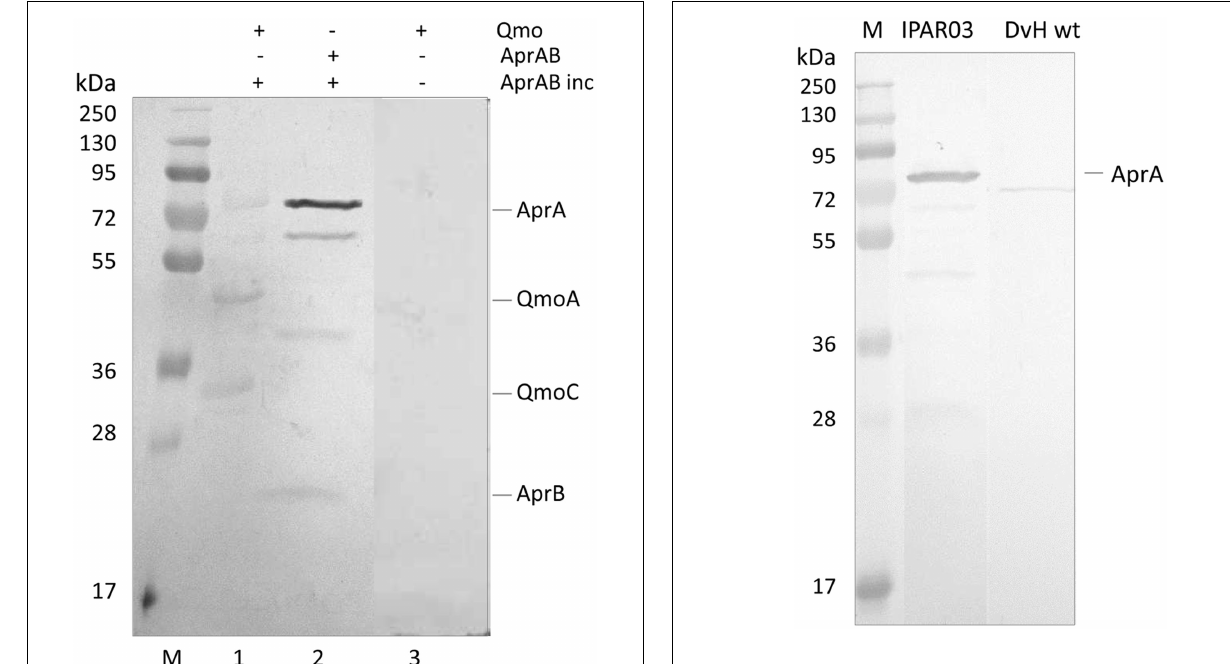
FIGURE 4 |Analysis of Pull-down assay. Strep -Tactin desthiobiotin elution products of soluble fraction from cells expressing STF-tagged QmoA (IPAR03) or wild-type D. vulgaris (DvH wt, negative control) analyzed by Western Blot with Anti-AprAB. M – Pre-stained molecular mass